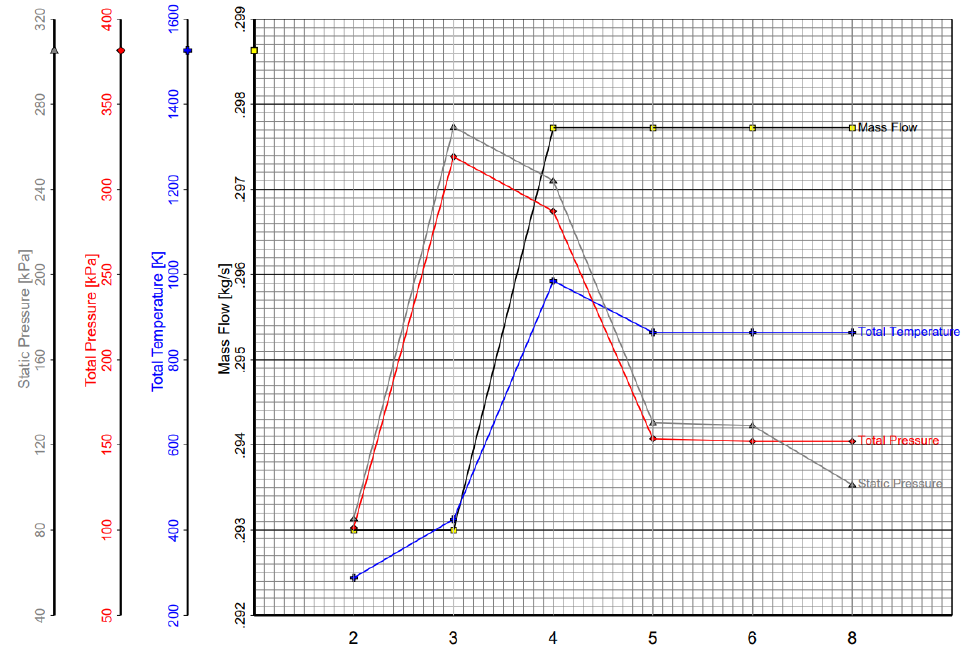
Figure 9. Station properties for the baseline turbojet simulation at 0.13 kN.